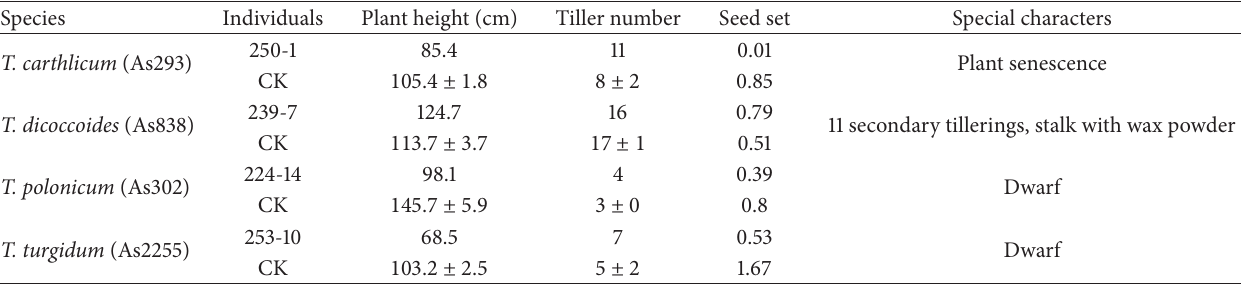
Table 3: Special agronomic characters of the materials under radiation